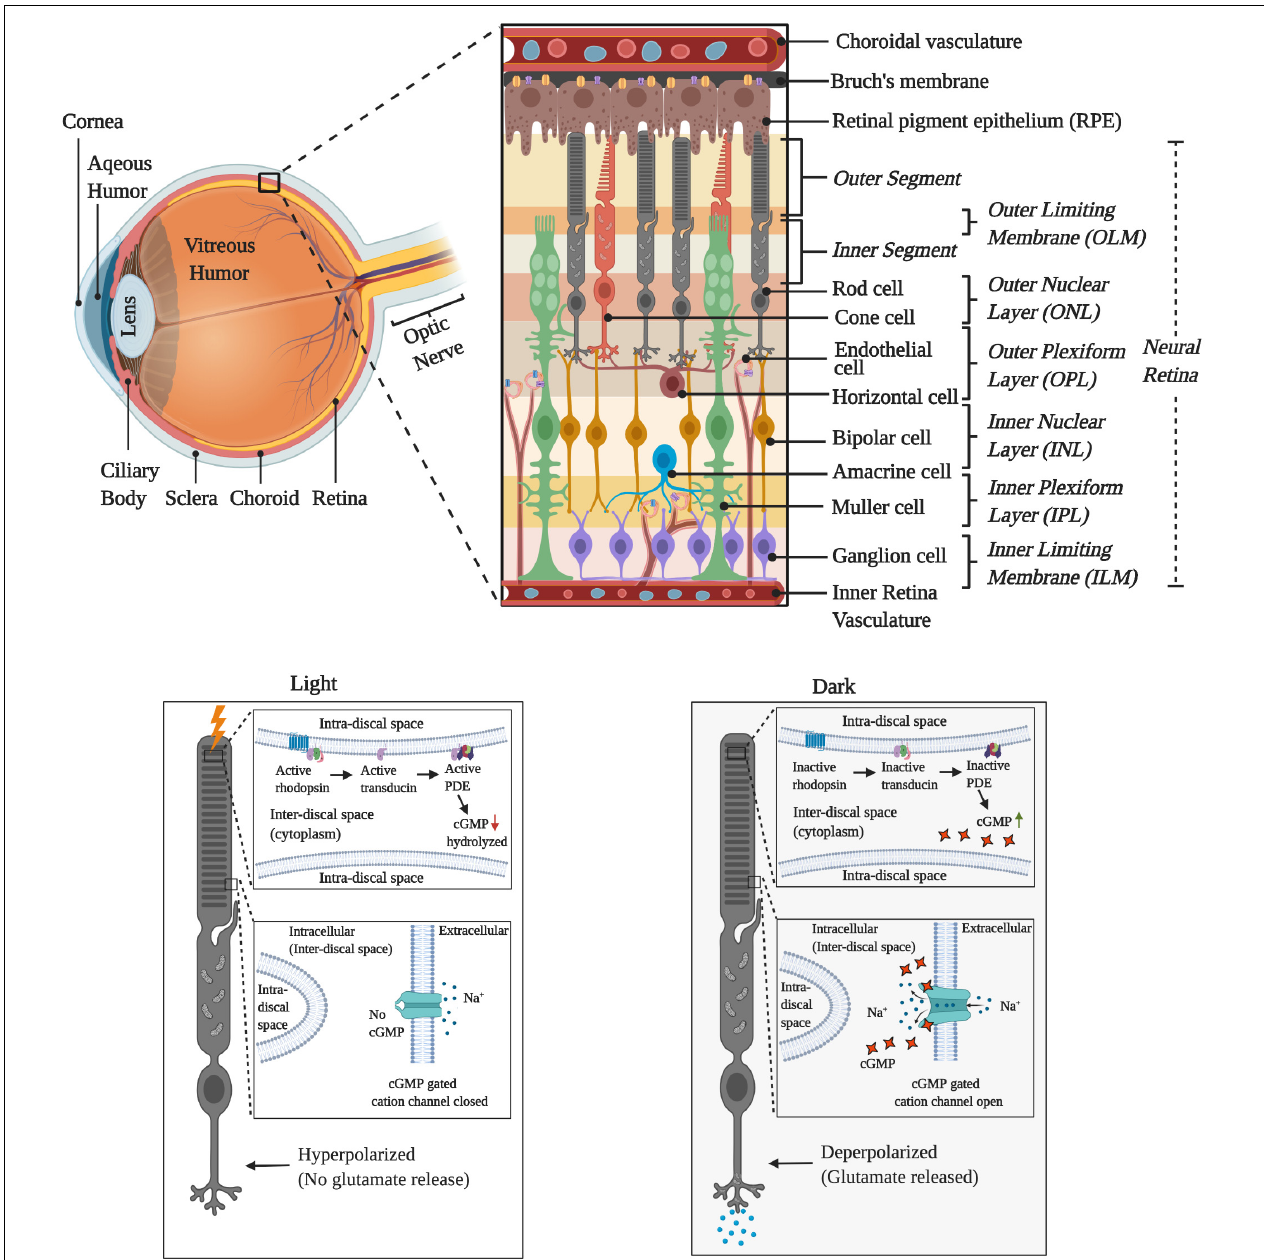
FIGURE 1 | Graphical illustration of the cellular layers of retina and the activity during the light and dark cycles.